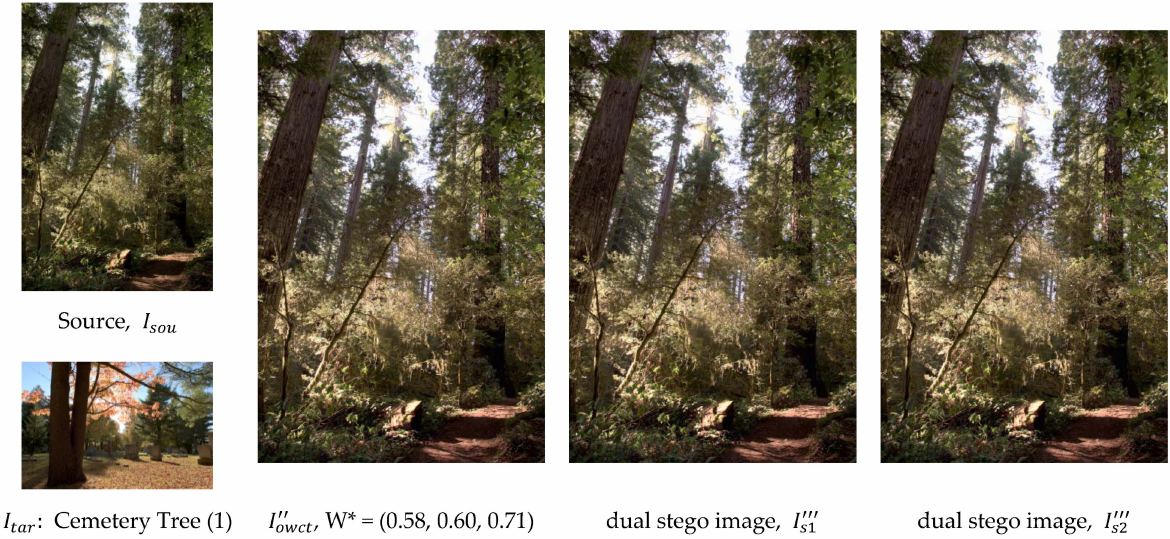
Figure 3. The visual inspection of two cases of stego images, “General Sherman,” produced by our scheme.